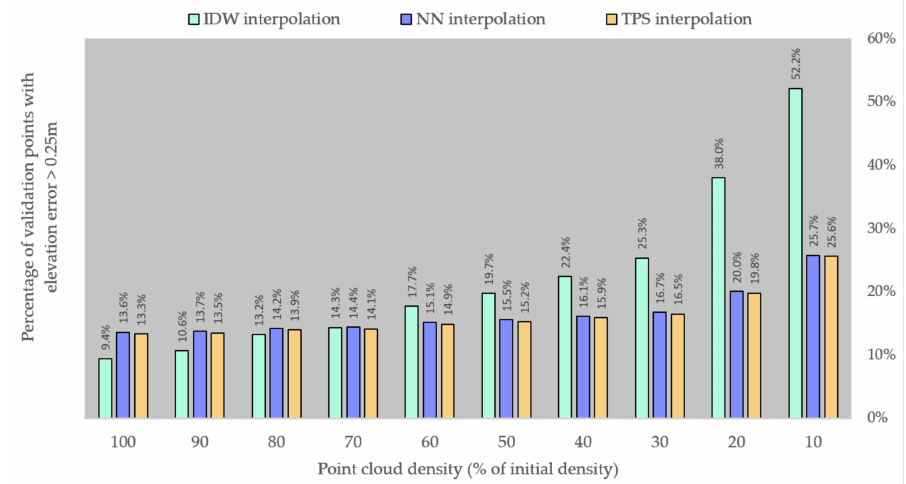
Figure 6. Percentage of validation points with an elevation error over 0.25 m.